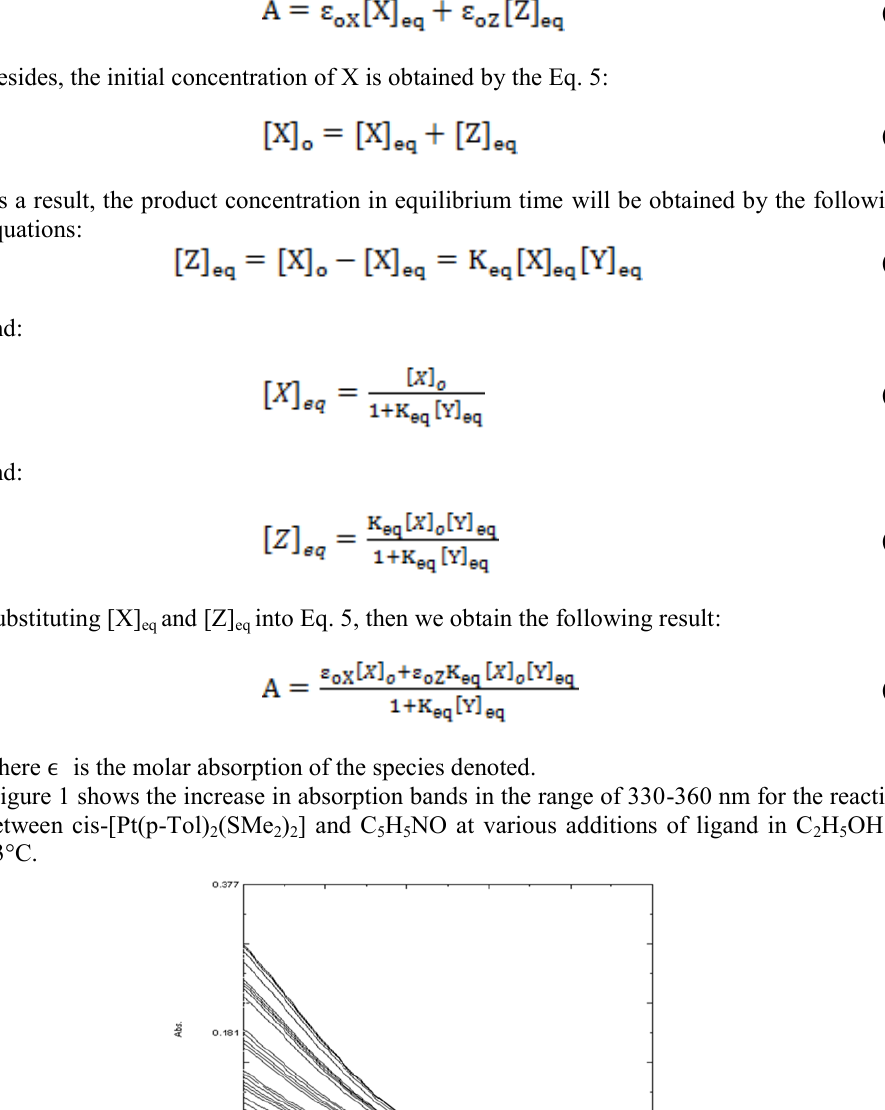
C H NO in C H OH at T=13 o C (molarities of entering ligand 5 5 2 5